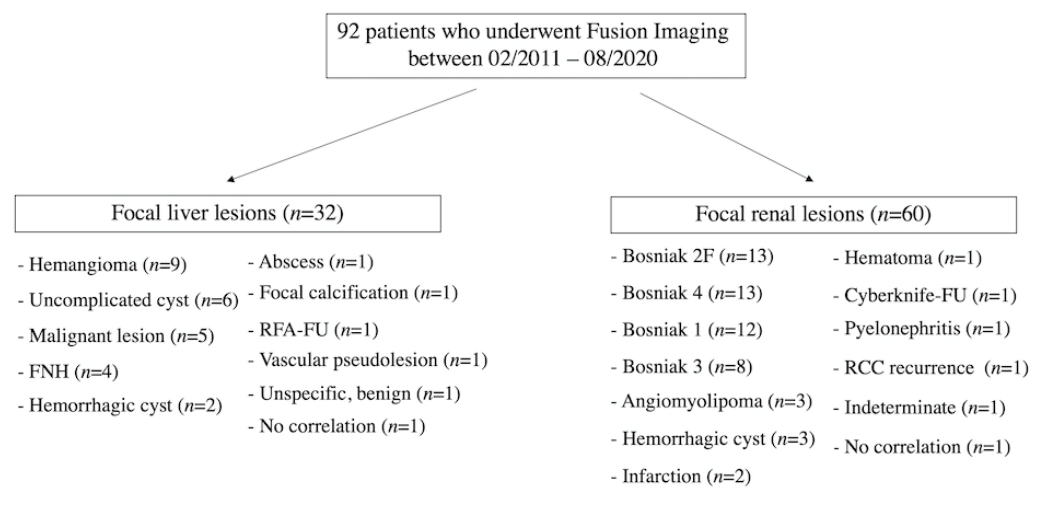
Figure 3. Flowchart illustrating included patients who underwent fusion imaging. FNH-focal nodular hyperplasia, RFA-FU-radiofrequency ablation-follow-up, Cyberknife-FU-Cyberknife-Follow-Up, RCC-renal cell carcinoma.